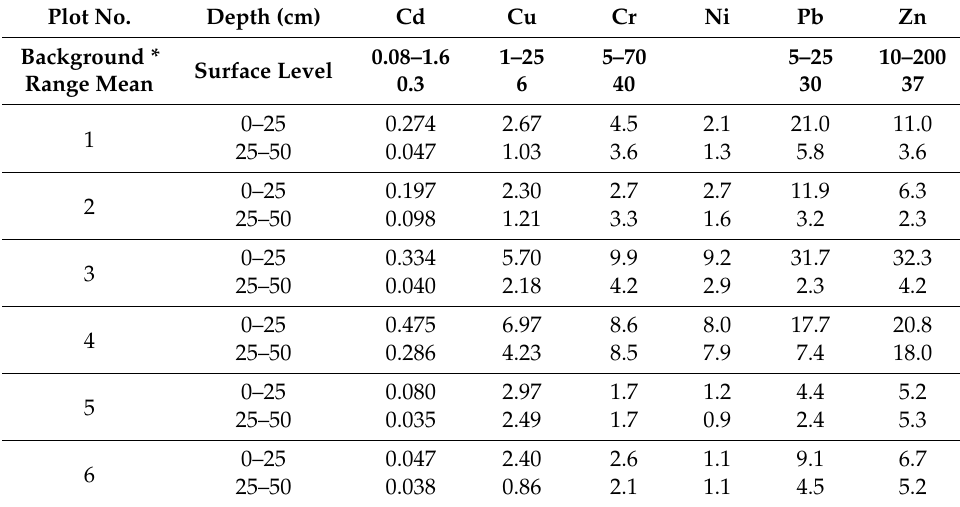
Table 3. Average contents of heavy metals in the soil in the landfill area (mg/kg). Plot No.